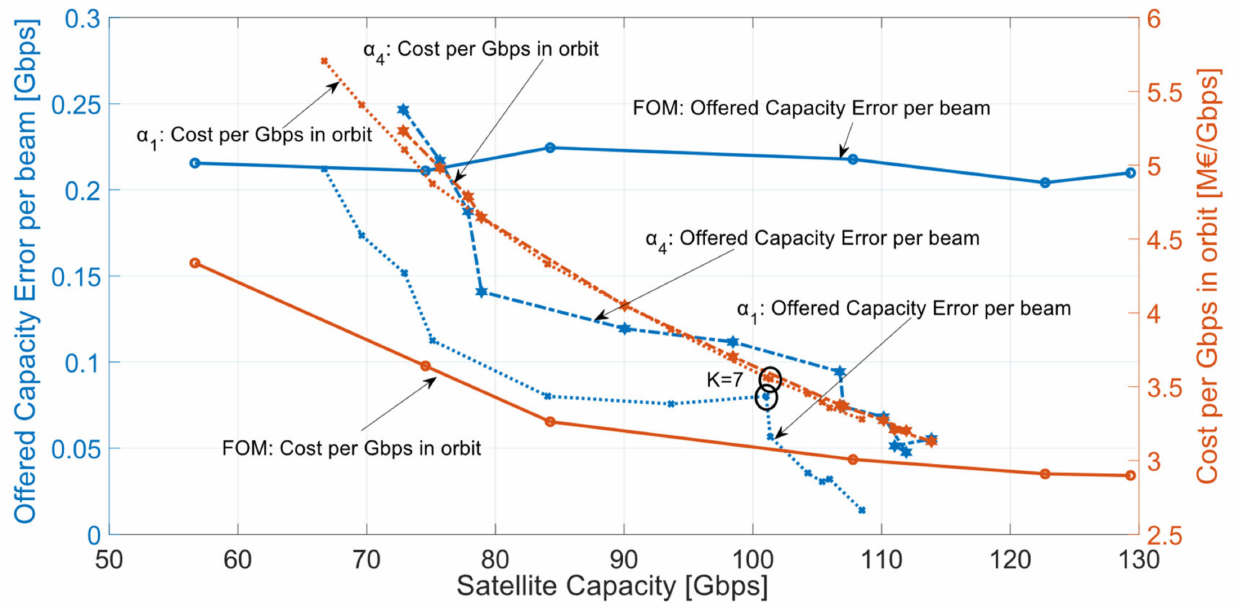
Figure 15. Performance comparison of methodology on Very High Throughput Satellite (VHTS) according to previous methodology (FOM)